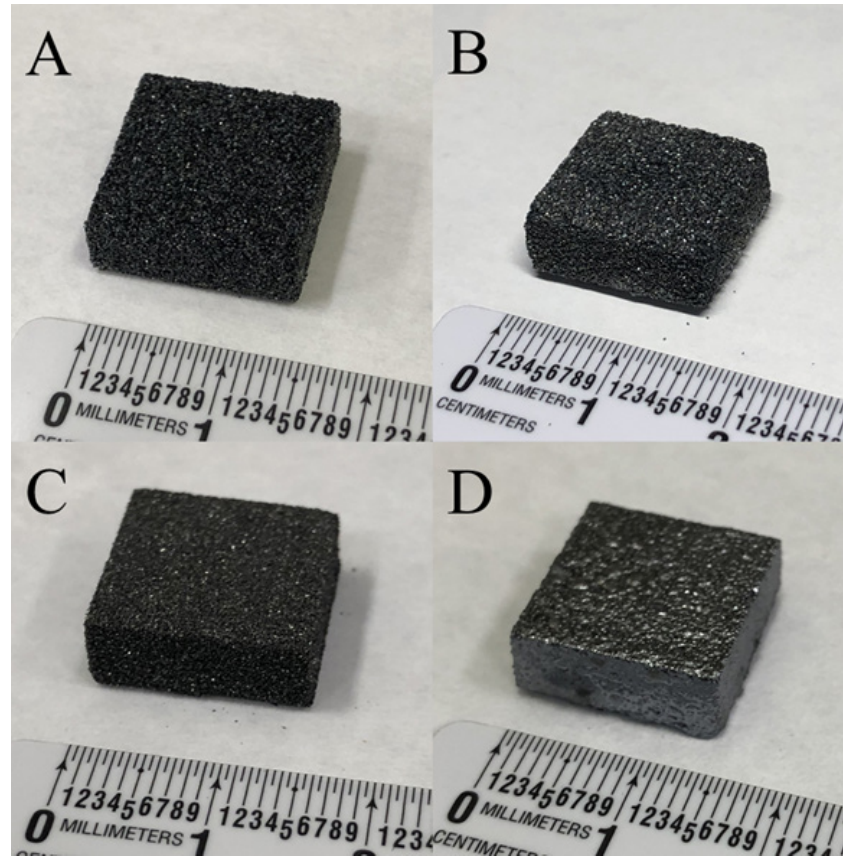
Table 2. Dimensions and densities of the preforms and composites.